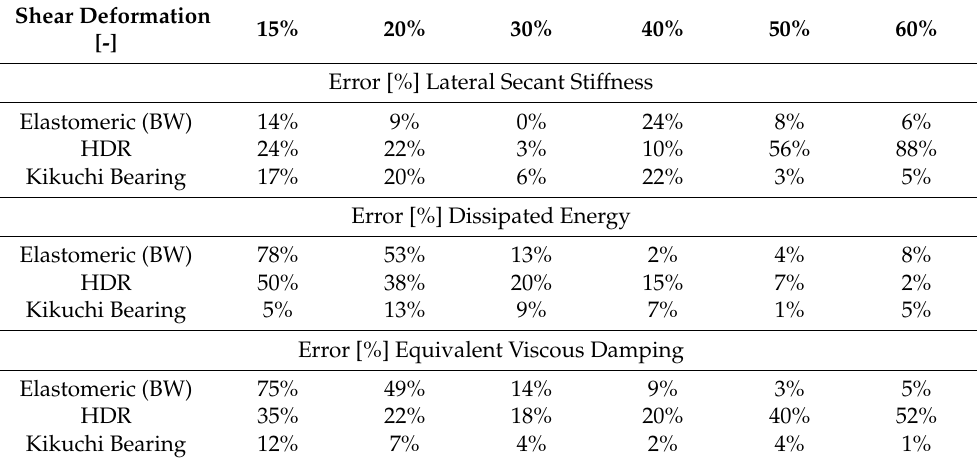
Table 10. Numerical Analysis versus Experimental Test results: Errors in terms of Effective Lateral Stiffness, Dissipated Energy and Equivalent Viscous